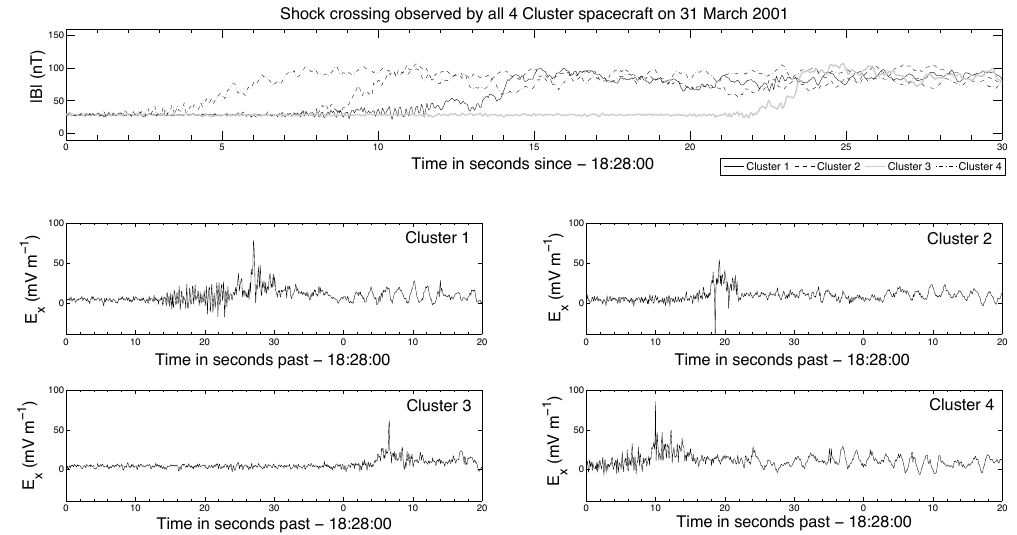
Fig. 1. Measurements made by the four Cluster spacecraft as they observed one of eleven bow shock crossing on 31 March 2001 at 18:28UT. The top panel illustrates the magnitude of the magnetic field profile measured by the four FGM instruments onboard each spacecraft. The four lower panels show the electric field measurements recorded by the relative EFW instruments over the same time period.